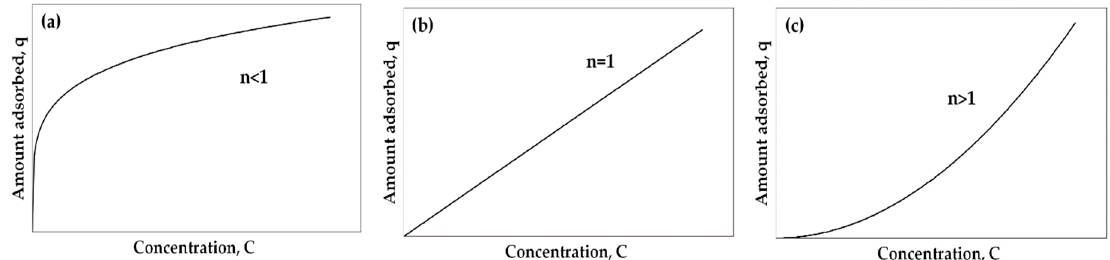
Figure 8. Forms of the Freundlich isotherm depending on the n value: ( a ) n < 1, ( b ) n = 1, and ( c ) n >